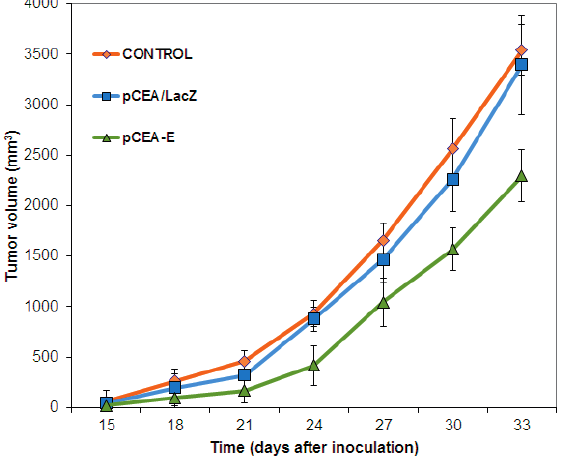
Figure 4. Tumor growth inhibition induced by pCEA - E . Treatment with pCEA - E induced a significant reduction in tumor volume at the end of the study period (33 days) in comparison with the growth of pCEA - LacZ -treated or untreated tumors (control) ( p < 0.05). Data represent the mean value ±